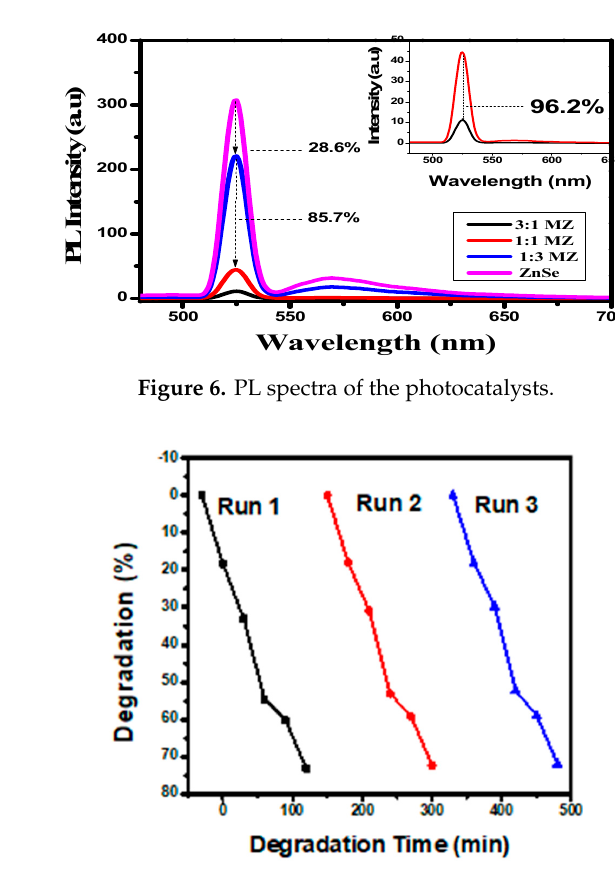
Figure 5. ( a ) Photodegradation rate of MoS 2 , ZnSe and composites, ( b ) kinetic plots of the photocatalytic degradation, ( c ) rate of degradation as a function of time and ( d ) absorption spectra of photodegradation